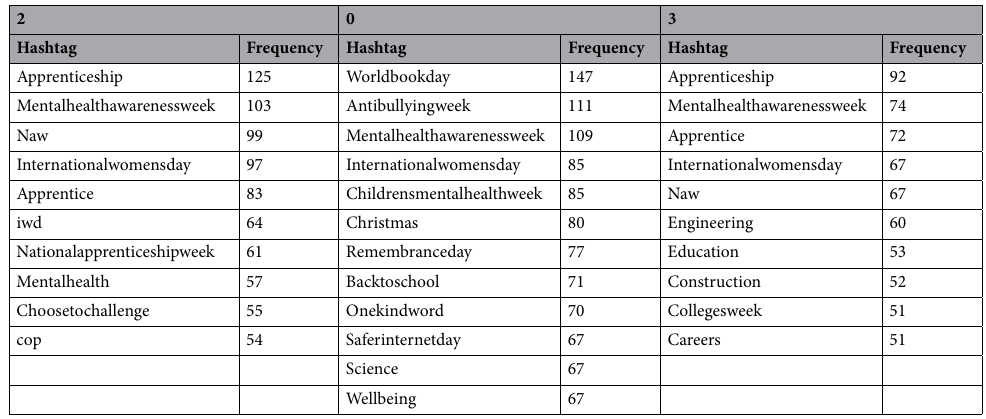
Table 7. Frequency of top 10 hashtags in the subcommunities with more than 50 nodes in Yellow